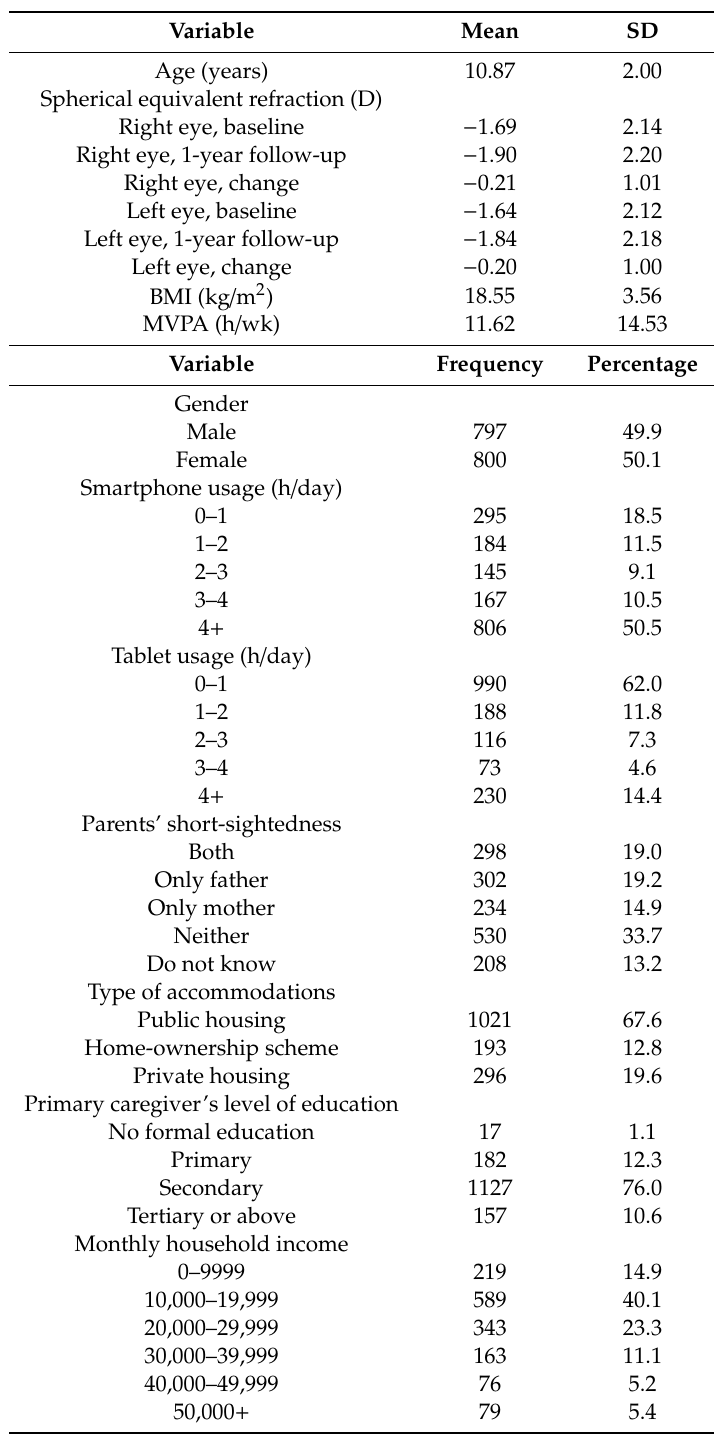
Table 1. Descriptive statistics ( n =